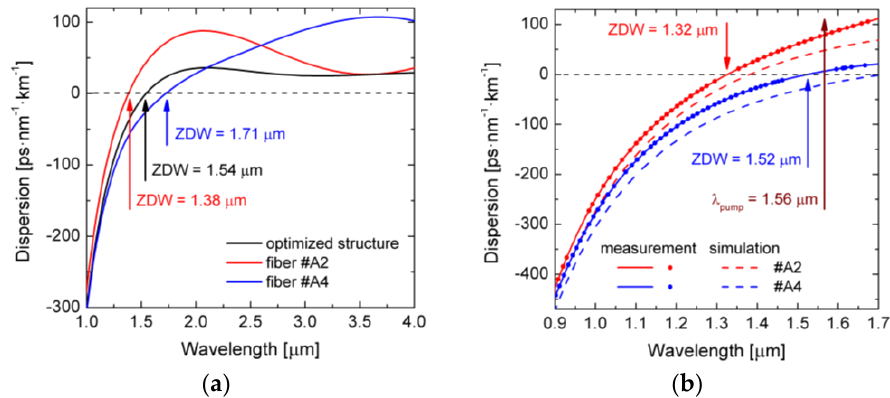
Figure 11. Dispersion characteristics of the fibers ( a ) #A2 and #A4 (simulation) compared to the dispersion characteristic of the ideal dispersion-optimized structure, ( b ) A2 and #A4 (both simulated and measured).